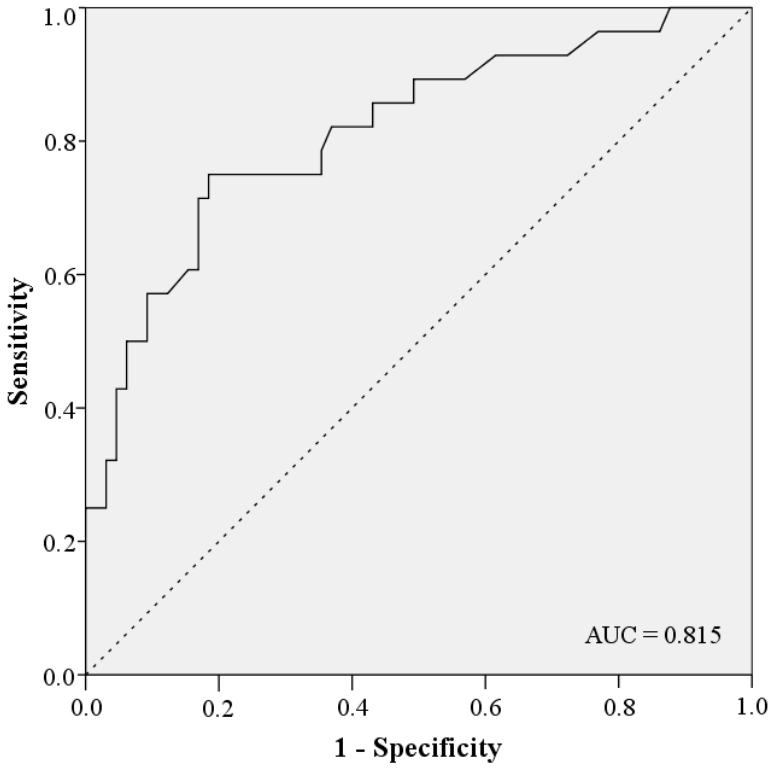
Figure 3. ROC Curve. Table 5. Univariate Analysis of Risk Factors on Complication.